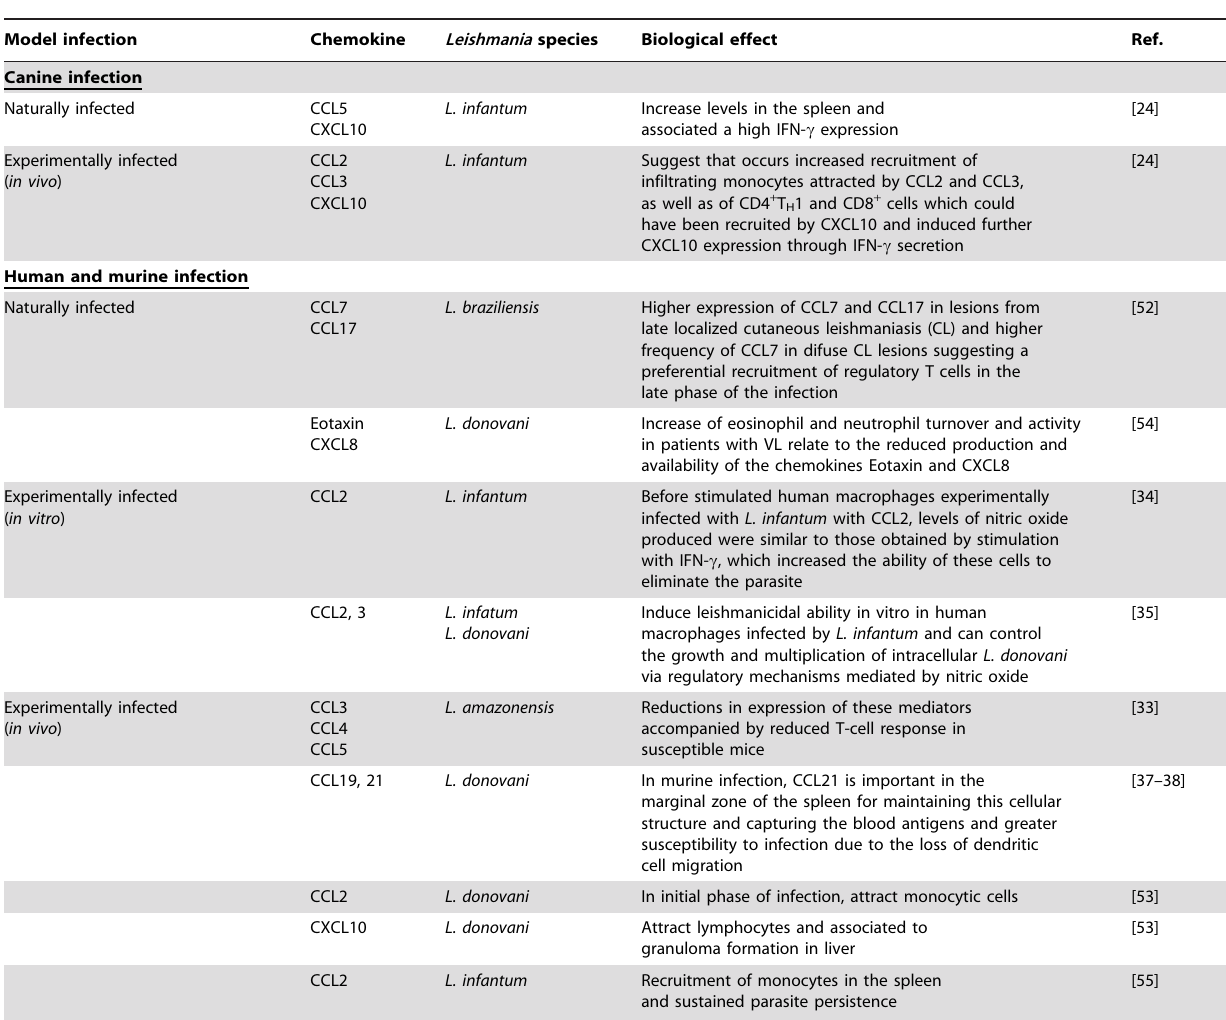
Table 2. Chemokines in Leishmania spp .